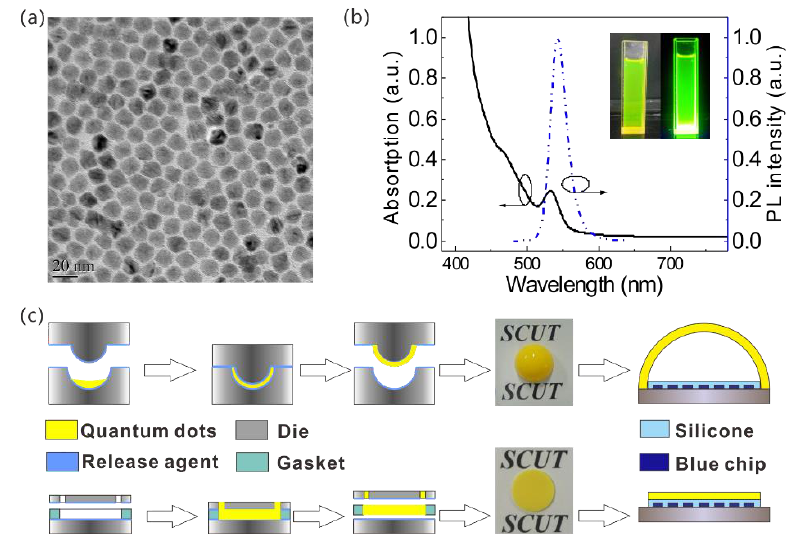
Figure 1. ( a ) Transmission electron microscopy (TEM) image of the CdSe/ZnS quantum dots; ( b ) Ultraviolet (UV)-visible absorption and PL spectrum of green-emitting CdSe/ZnS quantum dots; ( c ) Fabrication processes of WLEDs with spherical-shell and planar quantum-dot film.